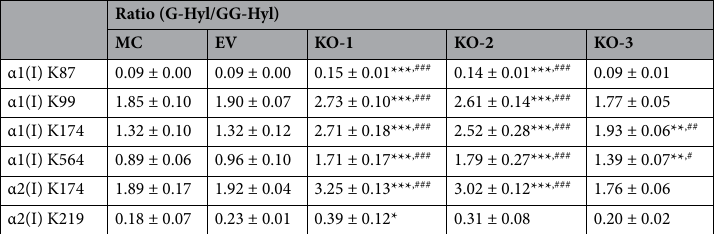
Table 9. Ratio of galactosyl (G)- to glucosylgalactosyl (GG)-hydroxylysine in type I collagen isolated from MC and KO clone. Values represent ratio of Hyl glycosylation calculated as G-Hyl/GG-Hyl. Values represent mean ± S.D. (n = 3) of triplicate for each group. Statistical differences were determined by Kruskal–Wallis one- way analysis of variance and means comparison with the controls by Dunnett’s method. Hyl hydroxylysine, G- galactosyl-, GG- glucosylgalactosyl-, MC MC3T3-E1, EV empty vector, KO knock-out. * p < 0.05, ** p < 0.01, and *** p < 0.001 between MC and KO; # p < 0.05, ## p < 0.01, and ### p < 0.001 between EV and KO (n = 3),